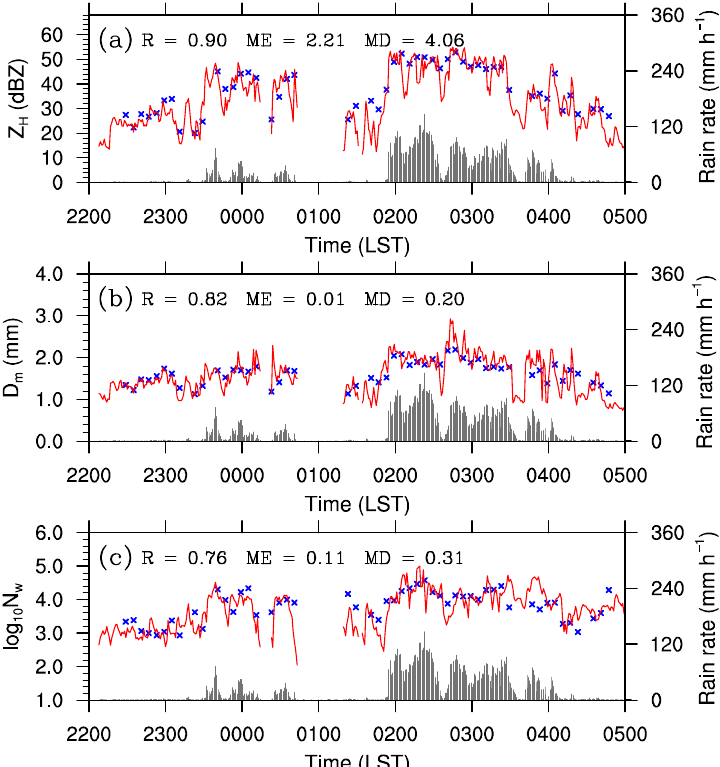
Figure 2. Temporal evolution of ( a ) radar reflectivity ( Z H , dBZ), ( b ) mass-weighted mean diameter ( D m , mm), and ( c ) logarithmic normalized intercept (log 10 N w , units of N w : mm − 1 m − 3 ) at the Enping station recorded by the 2DVD versus those retrieved from YJ S-POL at 1.5° elevation. R, ME, and MD represent the correlation coefficient, the mean error, and mean deviation of 2DVDs and the radar, respectively. Blue crosses and the red curve denote the 6 min radar-based results and the 1 min 2DVD observations, respectively, while the grey bars denote the rain rate observed by the 2DVD.